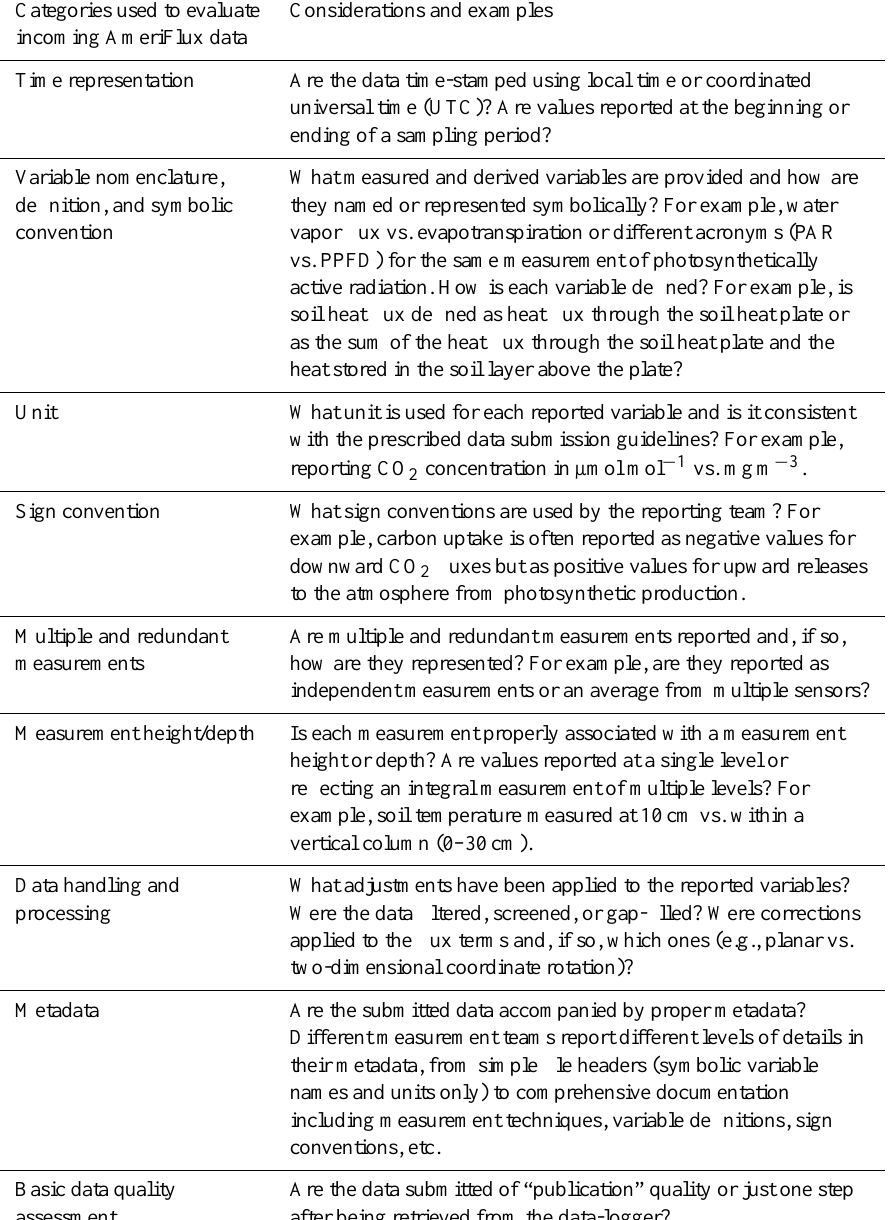
Table 1. Initial checks, evaluations, and clarifications performed by CDIAC on incoming AmeriFlux meteorological and flux data. These checks are necessary to determine the content and quality of the submitted data, as well as to identify corrections and derivations that must be made in subsequent